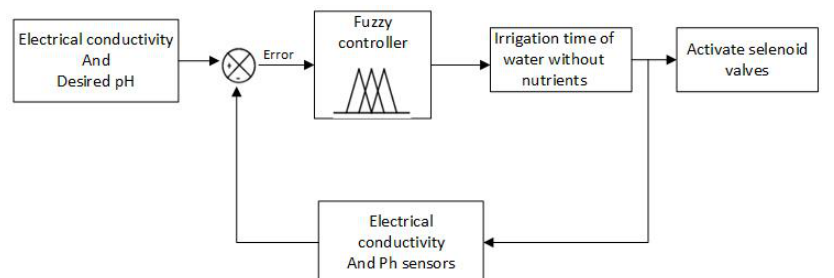
Figure 11. Fuzzy controller